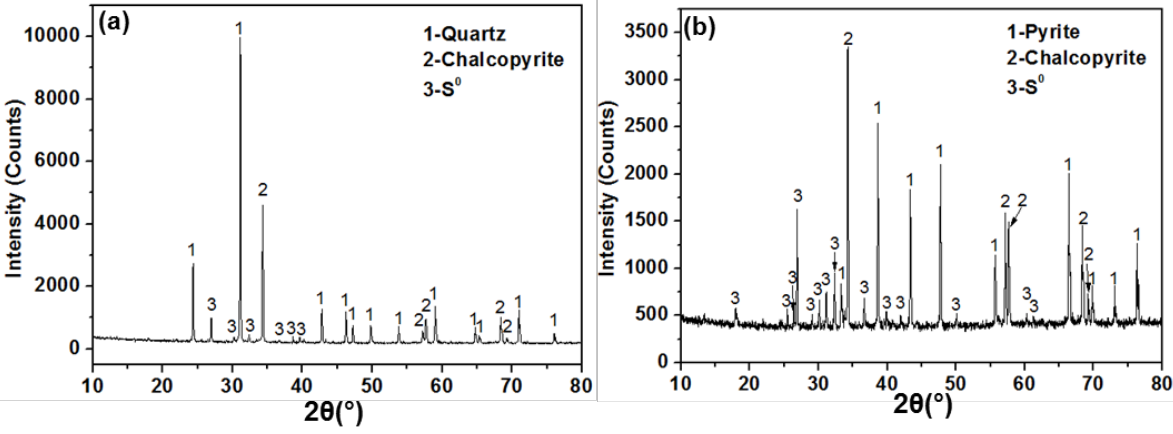
Figure 2. XRD patterns from the chalcopyrite leach residue subjected to 750 mV, 75 °C and pH 1.0: ( a ) chalcopyrite and quartz; ( b ) chalcopyrite and pyrite.